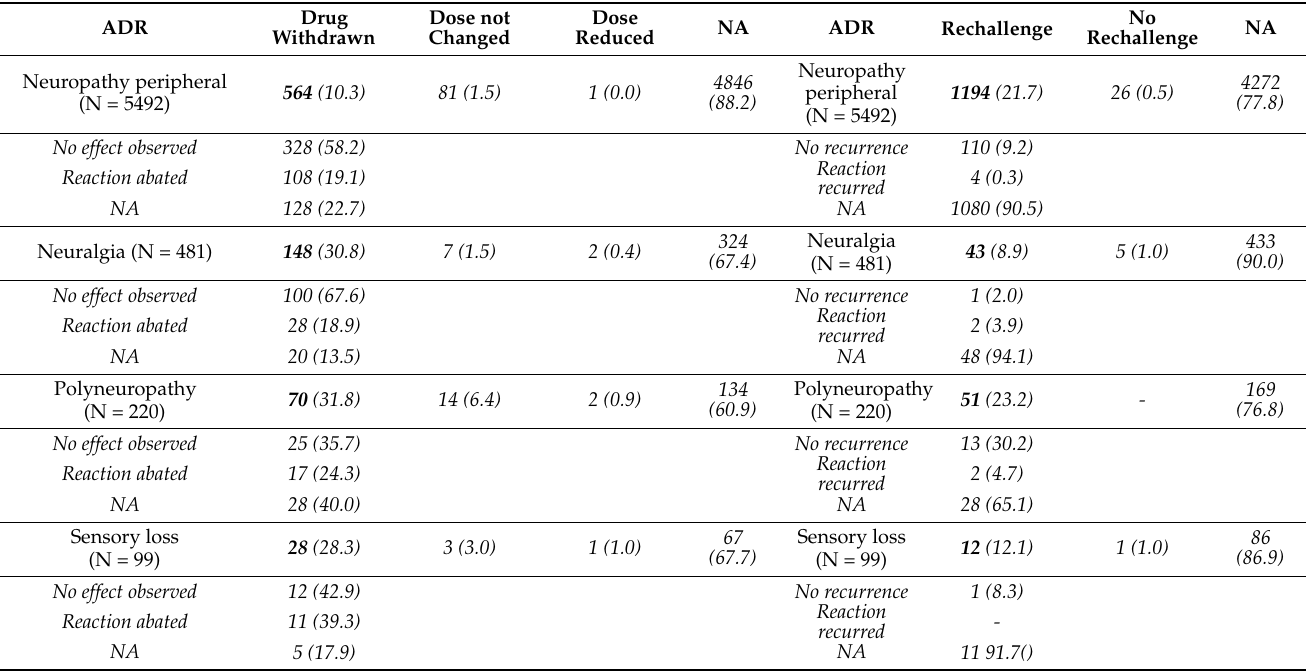
Table A1. Dechallenge/rechallenge action and